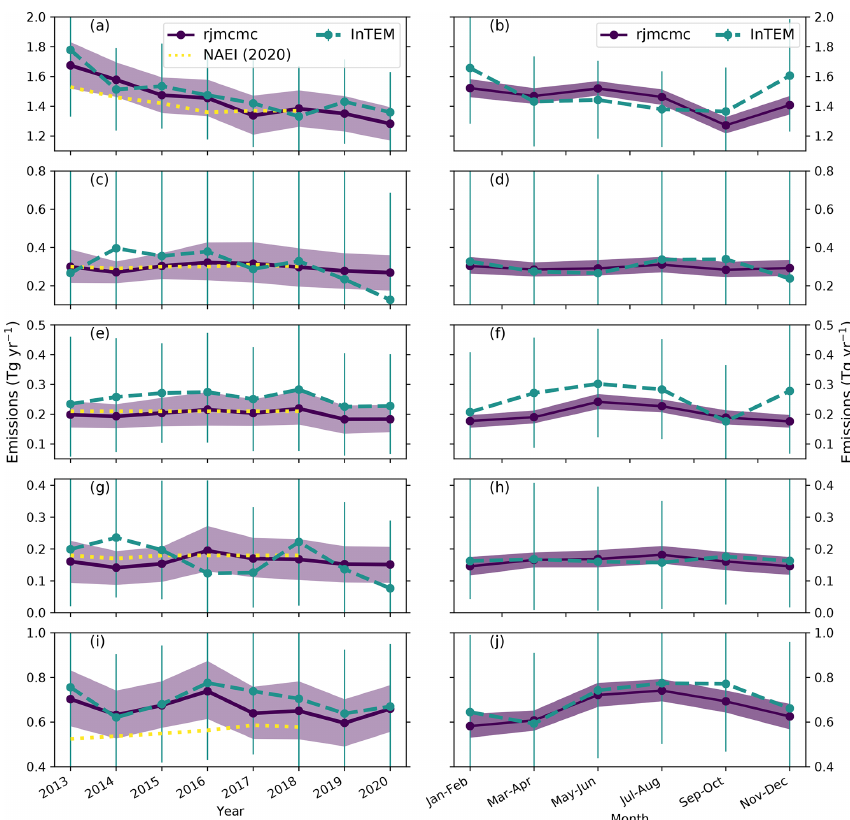
Figure 6. Annual emission estimates and seasonal cycles for the individual devolved administrations (DAs) of the UK and estimates for ROI. The figure shows (a) the rj-mcmc and InTEM annual mean estimates for England, (b) the mean seasonal cycle for England from rj-mcmc and InTEM, (c–d) Scotland, (e–f) Wales, (g–h) Northern Ireland (NI) and (i–j) the Republic of Ireland. The shading and error bars represent the 95% confidence intervals. Dotted lines represent the DA NAEI estimates from the 2020 inventory report, except for ROI, which represent the country’s national inventory